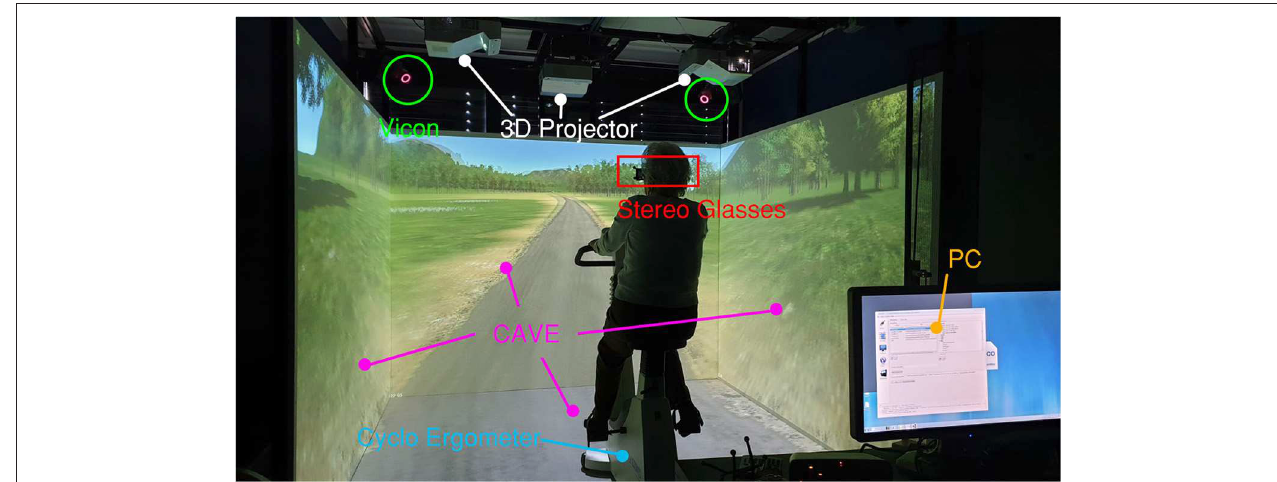
FIGURE 2 | The VR system, CAVE.